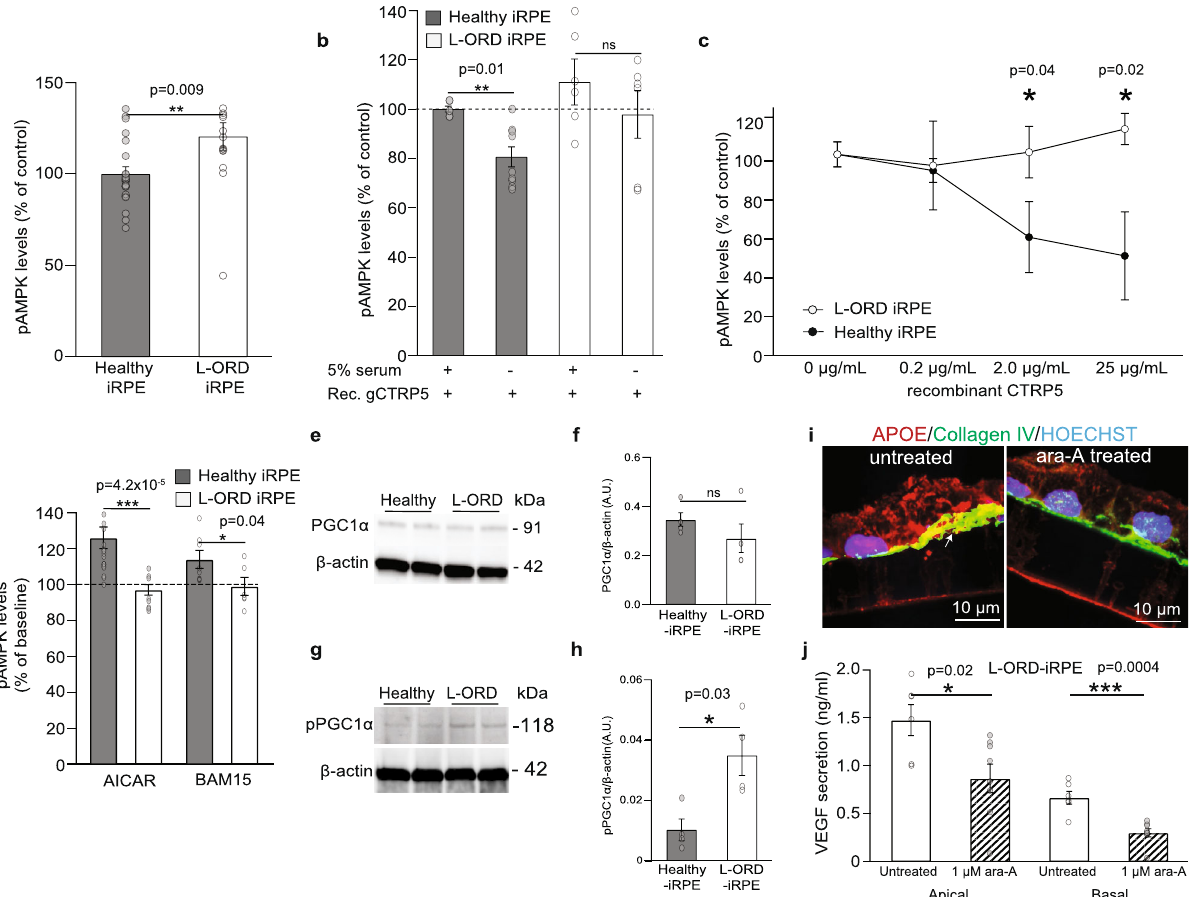
Fig. 3 Reduced antagonism of CTRP5 on ADIPOR1 results in altered AMPK signaling in L-ORD-iRPE. a pAMPK levels determined by ELISA in L-ORD- iRPE ( n = 15; 120.6% ± 0.08) compared to healthy-iRPE ( n = 21; 100% ± 0.04), cultured in 5% serum-containing media. b Effect of recombinant globular CTRP5 (0.2 µ g/mL) on pAMPK levels in the presence ( + ) or absence ( − ) of serum in healthy-iRPE (81% ± 4, n = 9) and L-ORD-iRPE (99% ± 1, n = 6), measured by ELISA. Data were normalized to the untreated condition (0 µ g/mL gCTRP5), considered as 100%. c Effects of recombinant full-length CTRP5 (0.2, 2, and 25 µ g/mL) on pAMPK levels in healthy-iRPE ( n = 6) and L-ORD-iRPE ( n = 6) incubated in serum-free medium for 5 h, measured by ELISA. d Effect of increasing cytosolic AMP with AICAR (an AMP analog, 2 mM) treatment or decreasing ATP with BAM15 (a mitochondrial uncoupler, 500 nM) on AMPK activity in healthy-iRPE and L-ORD-iRPE. All data were normalized to the 0% serum-containing untreated condition (AICAR: n = 20 for healthy- iRPE, n = 16 for L-ORD-iRPE; BAM15: n = 8 for healthy-iRPE, and n = 6 for L-ORD-iRPE). e Representative Western blot of PGC1 α expression in healthy and L-ORD-iRPE. f Quanti fi cation of Western blots for PGC1 α . Healthy-iRPE ( n = 4). L-ORD-iRPE ( n = 4). g Representative Western blot for phospho (S570)- PGC1 α in L-ORD-iRPE compared to healthy-iRPE. h Quanti fi cation of Western blots for phosphor (S570)-PGC1 α in healthy-iRPE ( n = 4) and L-ORD-iRPE ( n = 4). i APOE expression (red) in untreated and adenine 9-beta- d -arabinofuranoside (1 µ M, ara-A) treated L-ORD-iRPE. Collagen IV (green) marks RPE basal surface and nuclei (blue) are labeled with Hoechst 33342. ( n = 3 images each) Scale bar: 10 µ m. j ELISA detection of apical and basal VEGF secretion in untreated and adenine 9-beta- d -arabinofuranoside (1 µ M, ara-A) treated L-ORD-iRPE ( n = 6). ∗ p < 0.05; ∗∗ p < 0.01; ∗∗∗ p < 0.001; ns not signi fi cant, AU arbitrary